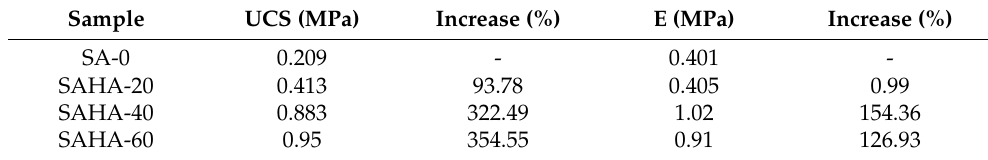
Figure 6. ( a ) Hydrogel before and ( b ) after fracturing by monotonic compression. Table 4. Ultimate compression test results and elastic modulus of hydrogel samples.